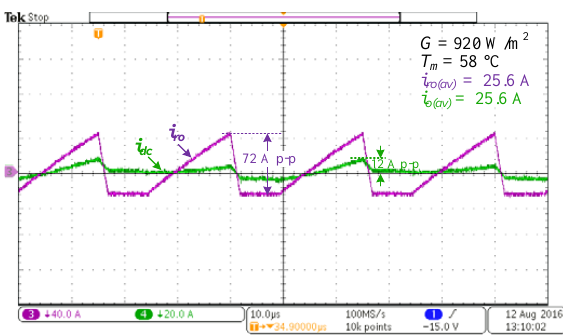
Figure 22. AC components of rectifier output current, i ro , and the converter output current waveform, i dc , recorded by Rogowski CWTUM/3/B current probe (average values of i ro and i dc and test conditions are marked on the figure; f sw = 20 kHz).